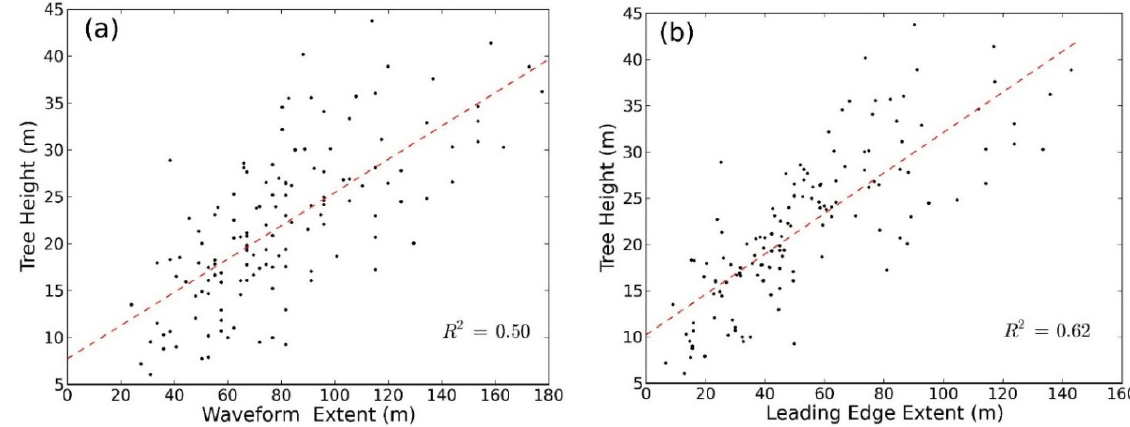
Figure 4. ( a ) Correlation between airborne LiDAR-derived tree height and GLAS waveform extent; ( b ) Correlation between airborne LiDAR-derived tree height and GLAS leading edge extent. R 2 represents the coefficient of determination. The red dashed lines are fitted lines between airborne LiDAR-derived tree height and GLAS